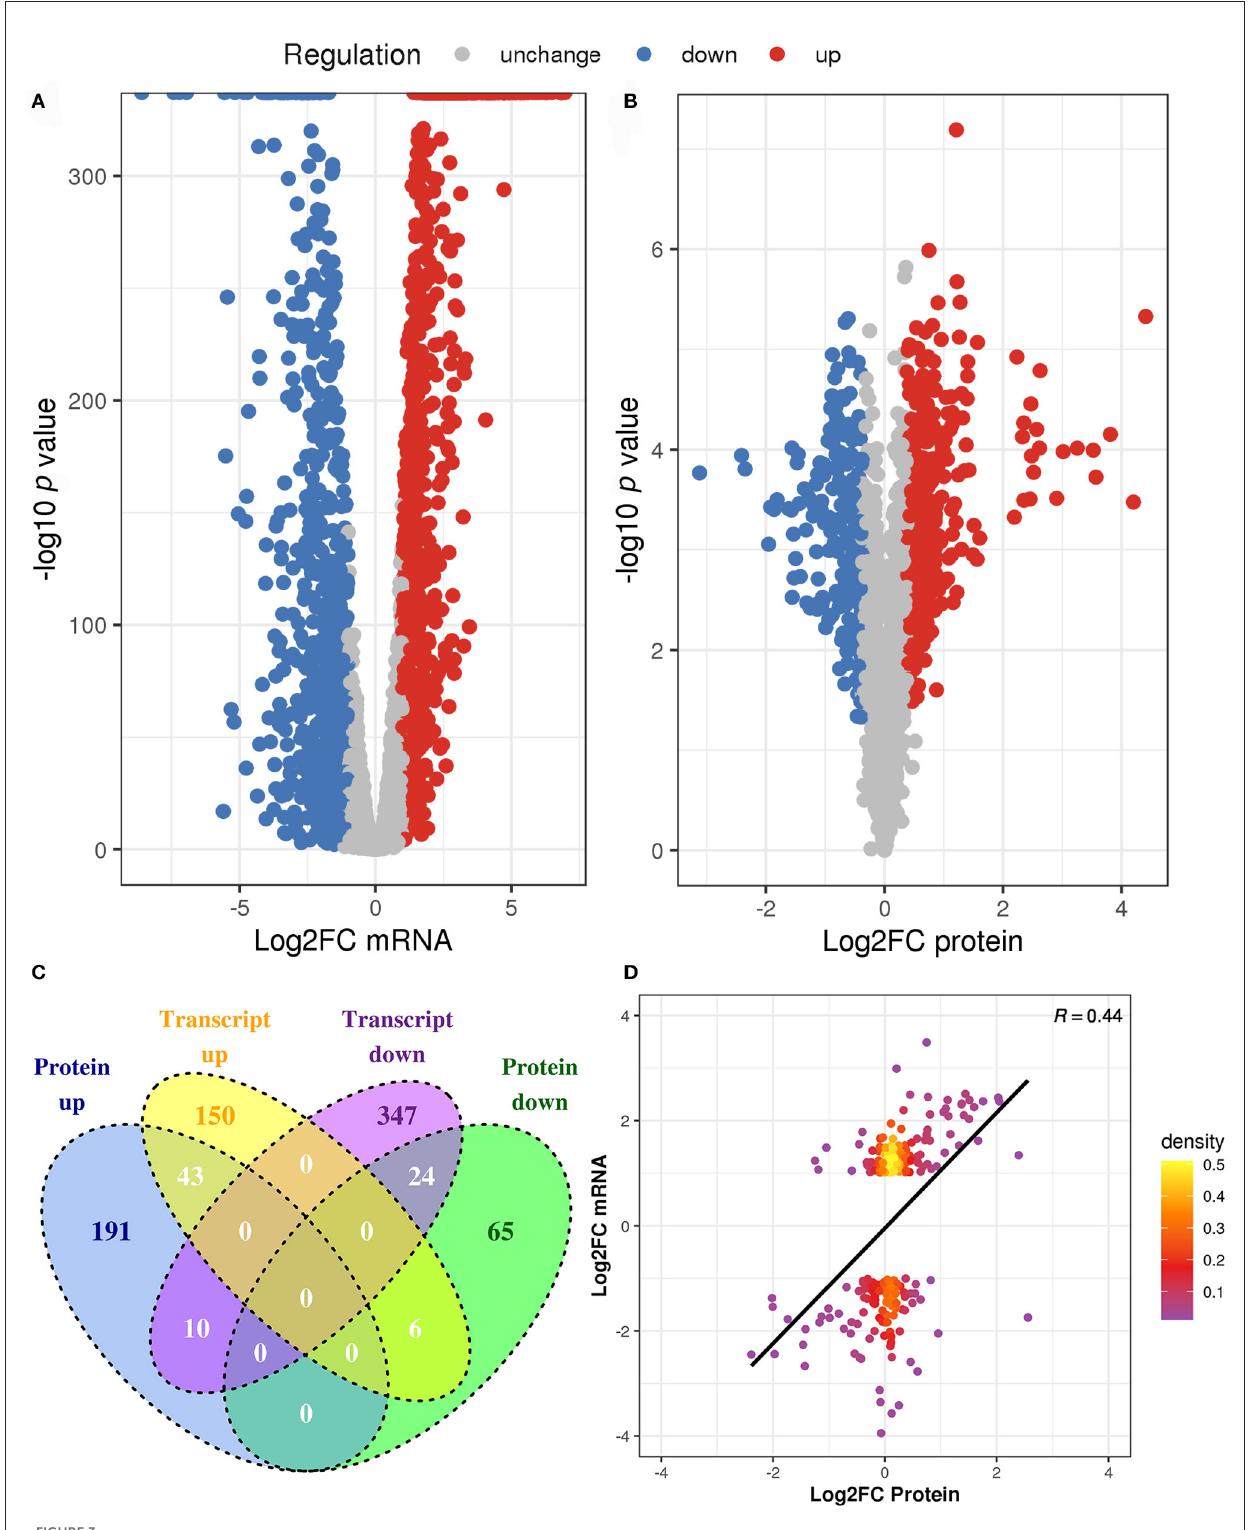
FIGURE3 The changes of L. paraplantarum RX-8 under co-culture in transcriptional and protein levels. (A) Indicates volcano plots in the DEGs of L. paraplantarum RX-8 under co-culture. (B) Indicates volcano plots in the DEPs of L. paraplantarum RX-8 under co-culture. (C) Venn diagram illustrates the count of DEGs and DEPs coherence regulation, when comparing L. paraplantarum RX-8 in co-culture and mono-culture. (D) Correlation between DEGs and DEPs L. paraplantarum RX-8 under